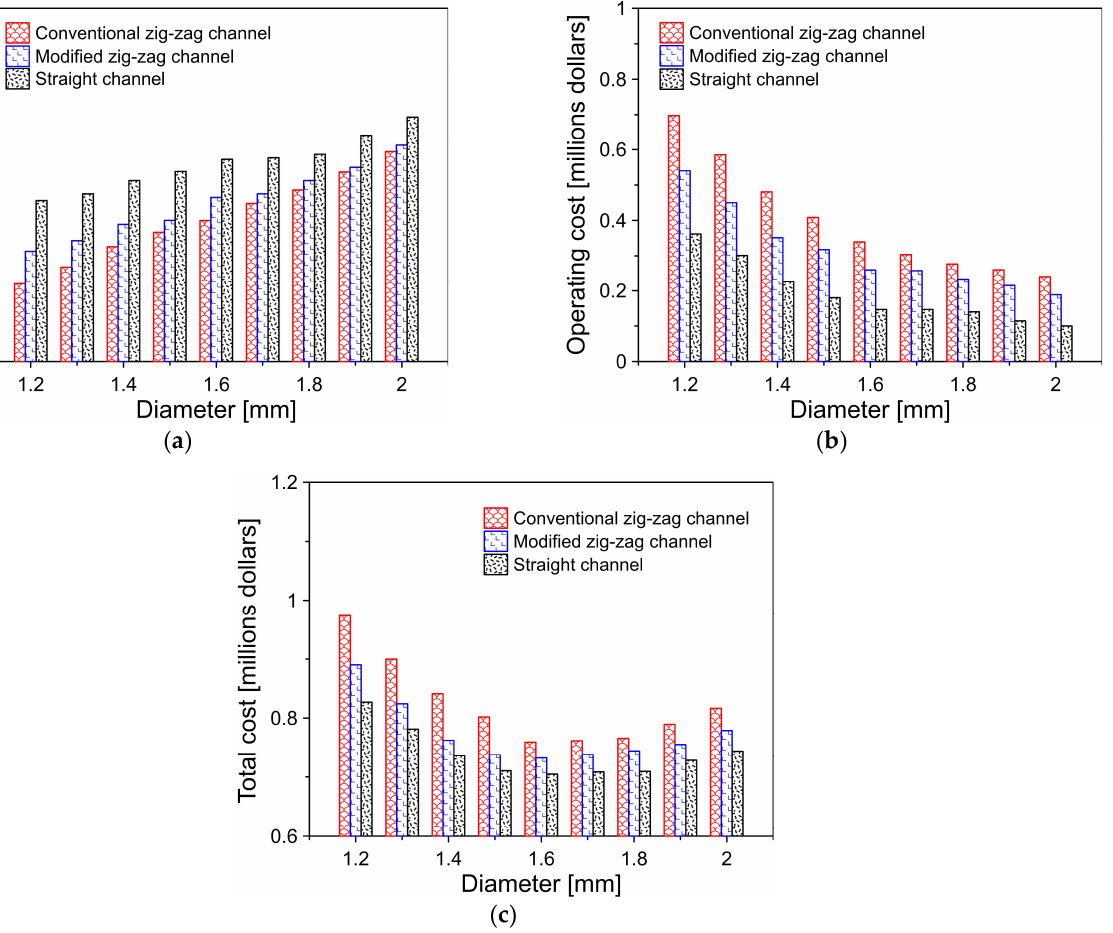
Figure 21. The economic cost for different channel configurations in the PCHE: ( a ) capital cost; ( b ) operating cost; ( c ) total cost.